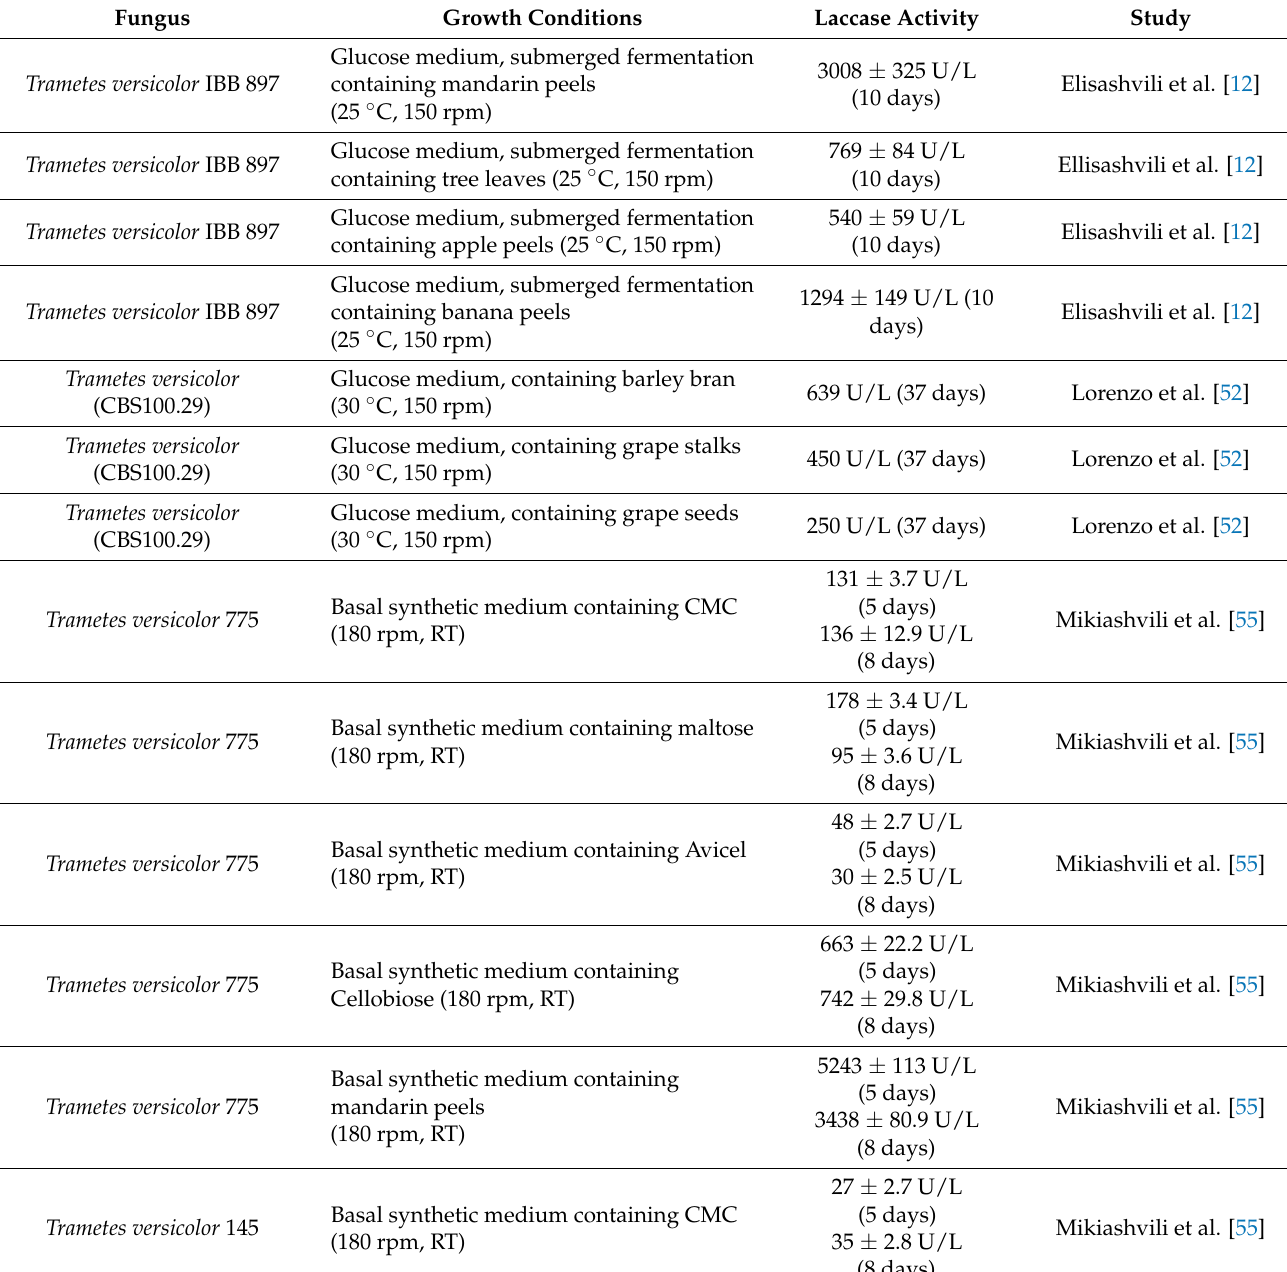
Table 2. Comparison of laccase activities of fungi grown in the presence of various lignocellulosic substrates. Fungus Growth Conditions Laccase Activity Study Trametes versicolor IBB